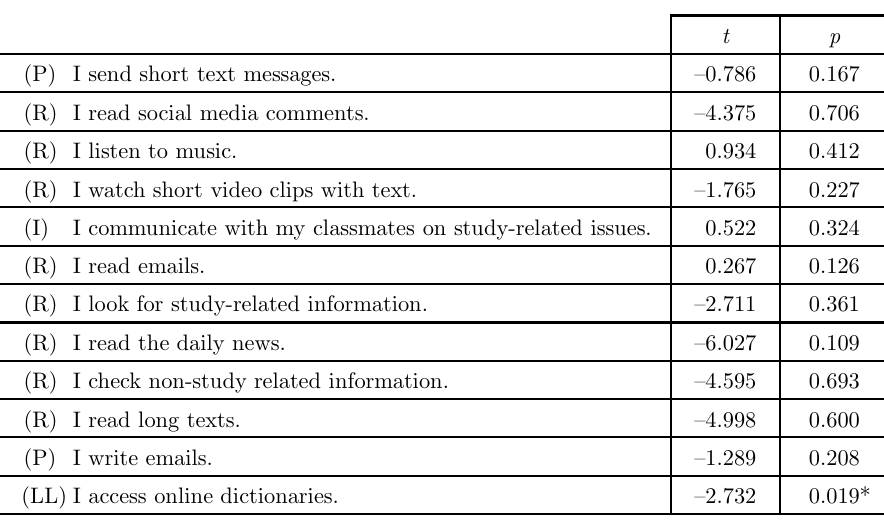
Effect of the predominant language for online use on